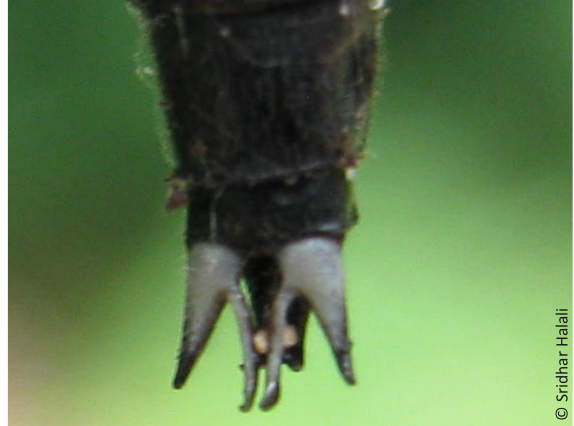
Prothorax: Black with anterior collar greenish-yellow. Thorax: Mesothoracic collar confluent